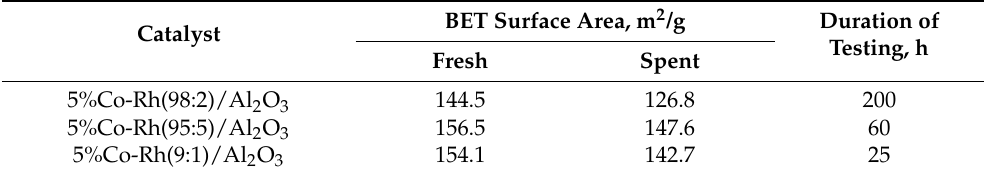
Table 1. BET surface area of the 5%Co-Rh/Al 2 O catalysts. BET Surface Area, m 2 /g Duration Catalyst